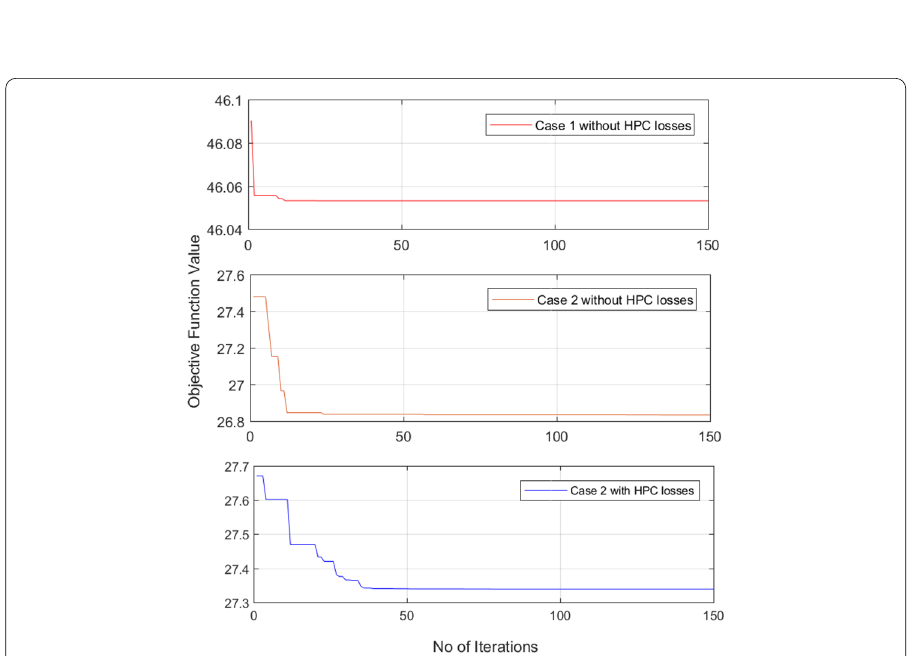
Fig. 5 Case-wise convergence characteristics obtained by BO algorithm for 33-bus hybrid AC/DC distribution